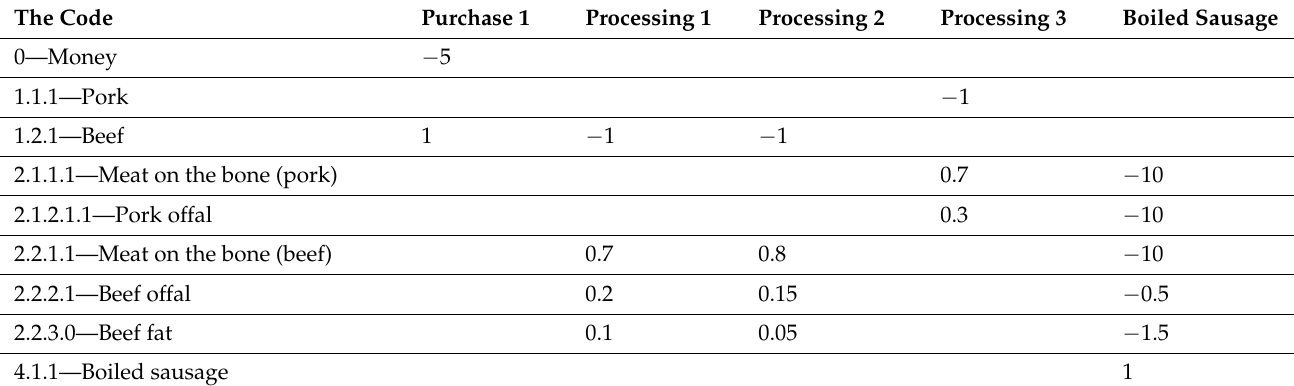
Table 2. Fragment of a table of manufacturing operations.